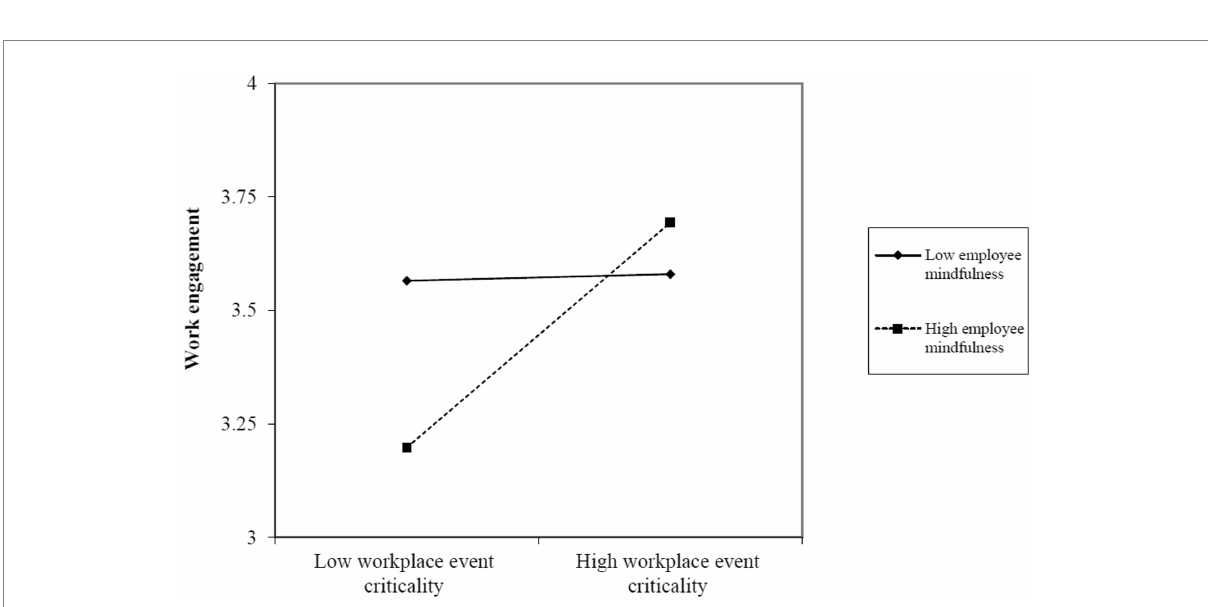
FIGURE 3 Interactive effects of workplace event criticality and employee mindfulness on work